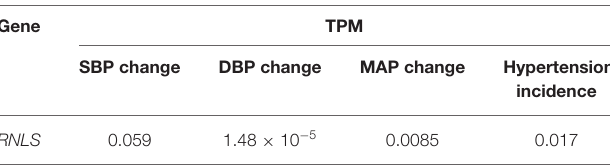
TABLE 3 | Gene-based associations of RNLS with longitudinal BP changes and hypertension incidence over 14 years of follow-up.